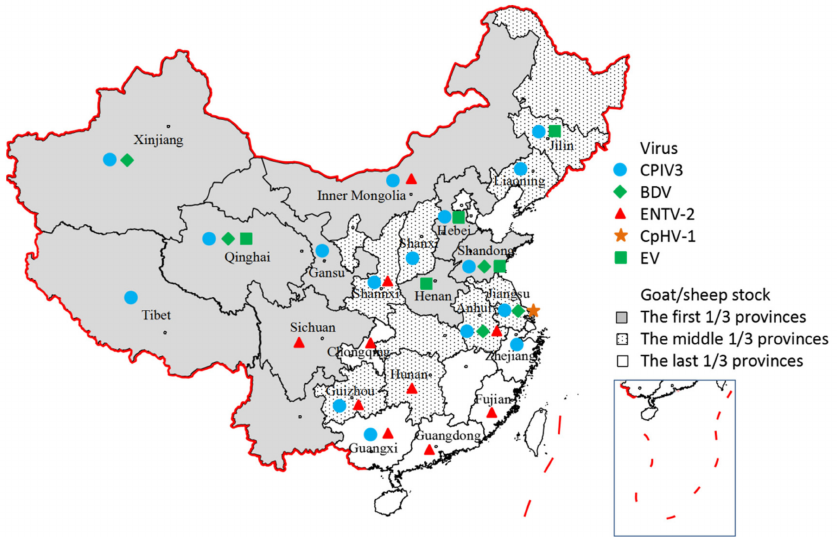
Figure 2. Prevalence of the emerging viruses in different provinces of China. Different symbols represent different emerging viruses. The different color in each province region represents the ranking of goat/sheep stock. Table 2. Sero-epidemiological study against CPIV3 in different regions of